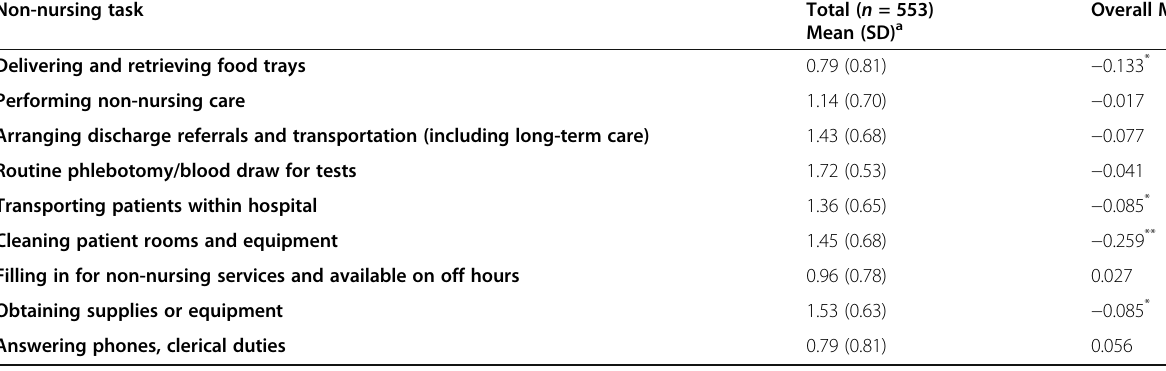
Table 4 Spearman rank-order correlations between overall missed nursing care and non-nursing tasks Non-nursing